Question: In a single sentence, describe what this figure presents.
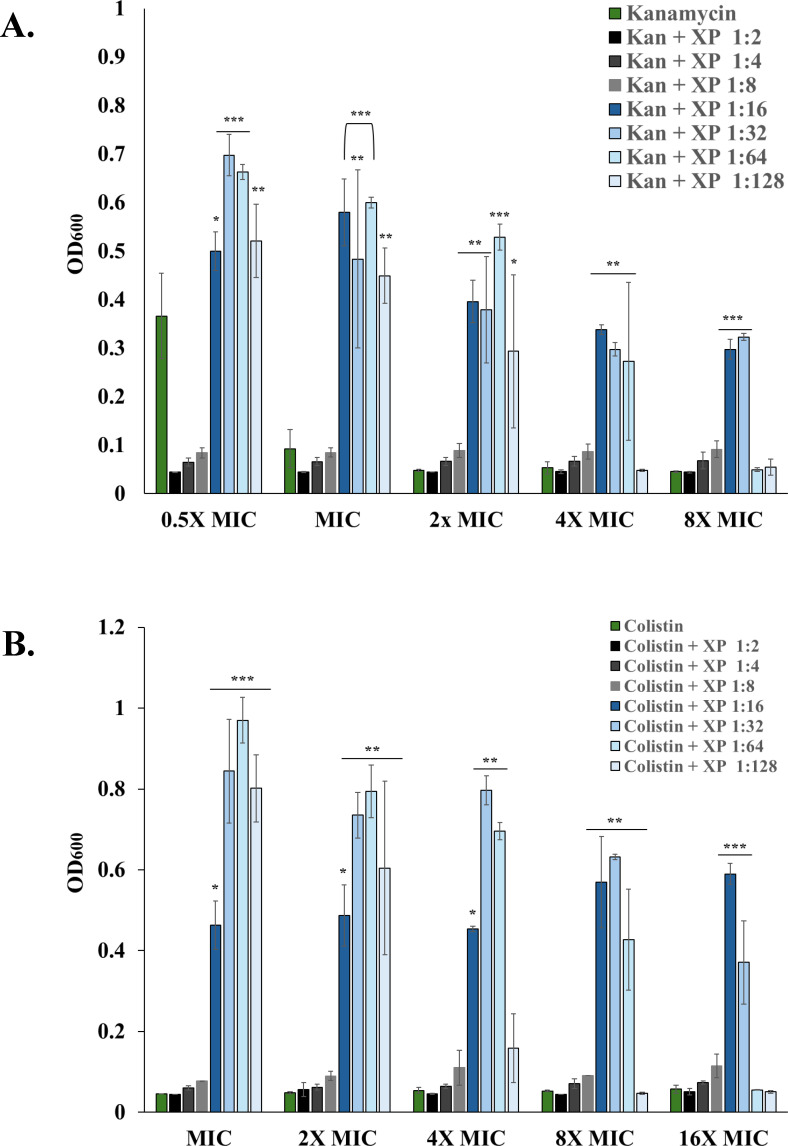
Answer: Exposure to diluted Xperience allows for growth in bacteriostatic concentrations of multiple classes of antibiotics. Checkerboard assays were used to evaluate the effect of co-treatment of K. pneumoniae 43816 with Xperience and ( A ) kanamycin and ( B ) colistin. N = 3 independent assays. Bars represent the standard error from the mean. Statistical comparisons are against antibiotic treatment alone at the same dose. * P < 0.05, ** P < 0.005, *** P < 0.0001.